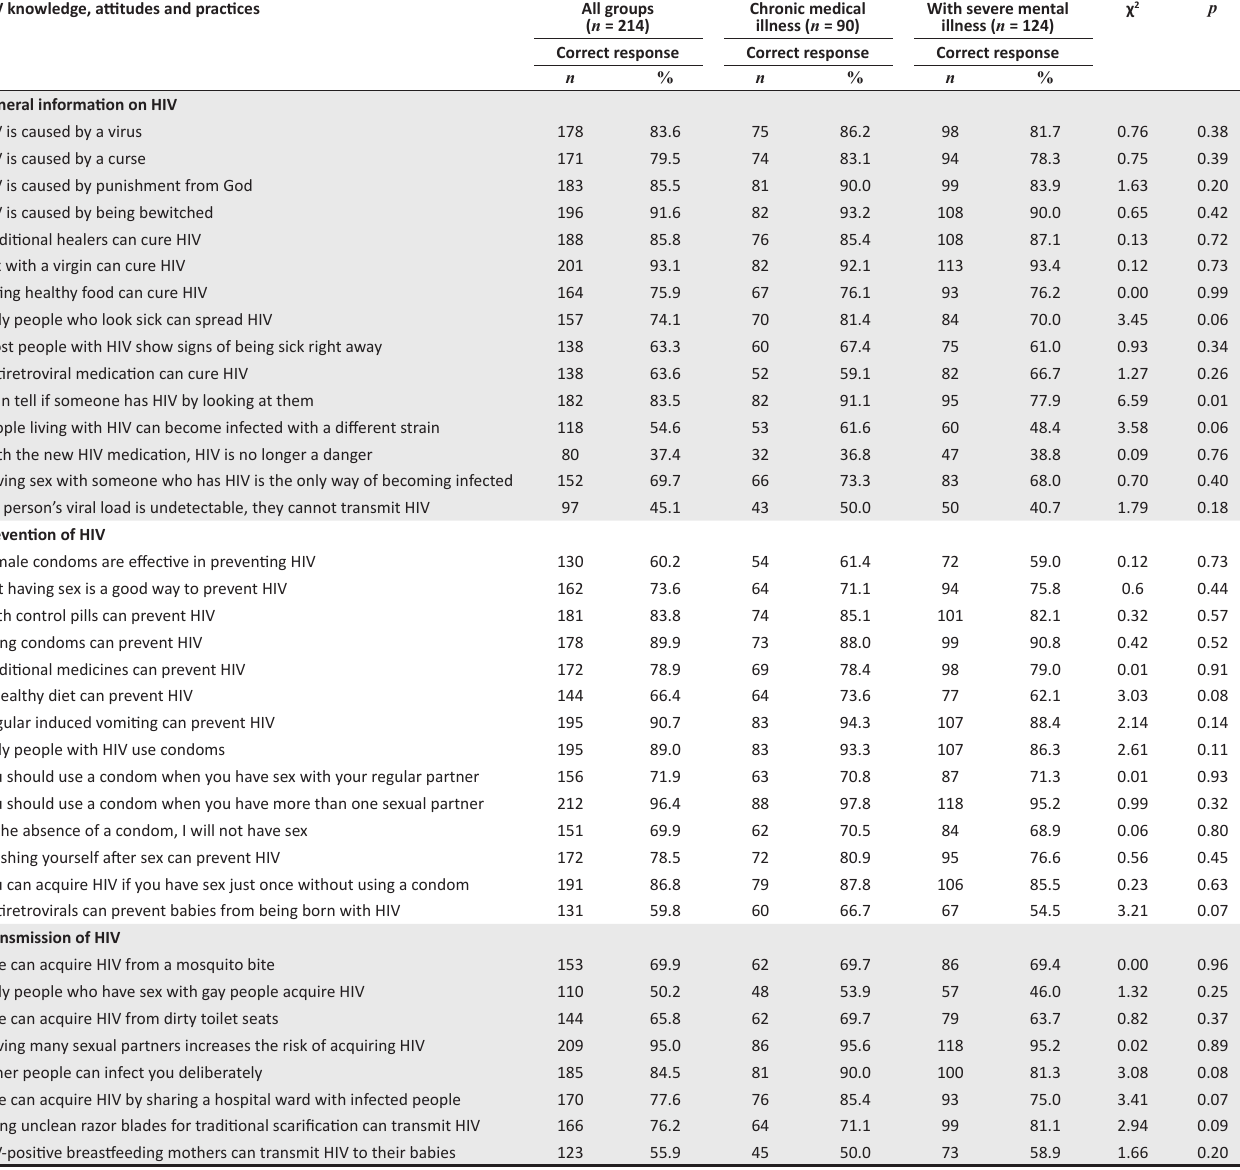
TABLE 2: Participants responses to general information, prevention and transmission of HIV. HIV knowledge, attitudes and practices